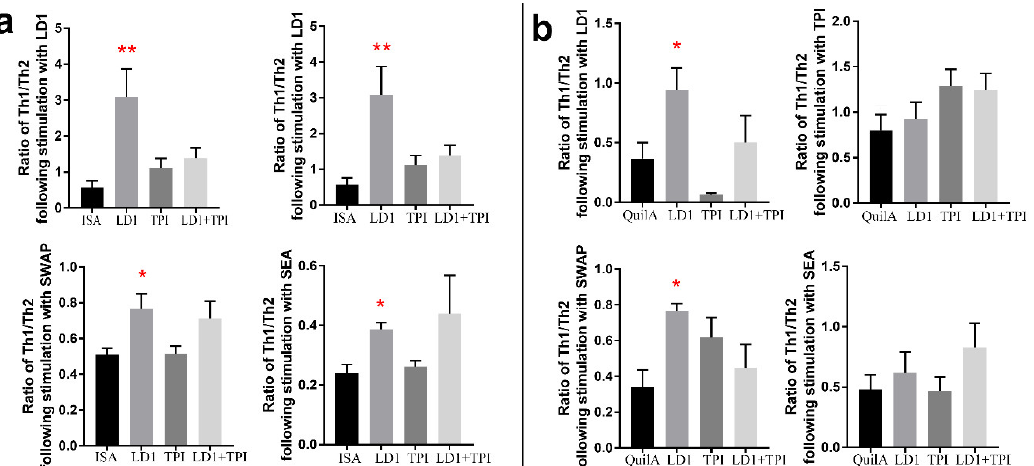
Figure 4. Ratio of Th1/Th2 in splenic CD4 + T cells obtained from mice vaccinated with SjLD1, SjTPI and SjLD1 + SjTPI adjuvanted with ISA or QuilA at 6 weeks post-challenge. The ratio of Th1/Th2 was determined by the proportion of IFNγ- and IL-4-producing splenic CD4 + T cells isolated from mice vaccinated with SjLD1, SjTPI and SjLD1 + SjTPI adjuvanted with ( a ) ISA and ( b ) QuilA, respectively, after stimulation with rSjLD1, rSjTPI, SWAP and SEA (* p value ≤ 0.05; ** p value ≤ 0.001).